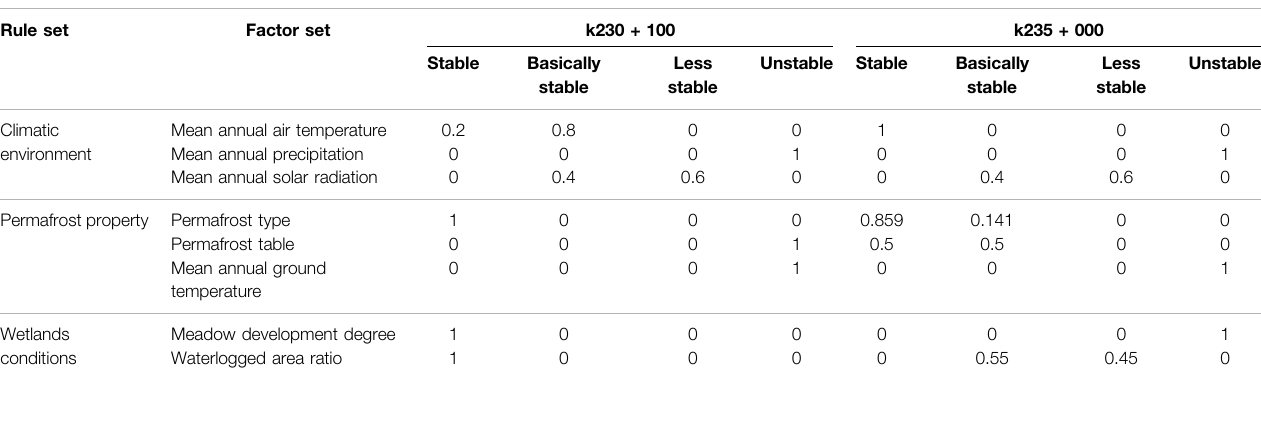
TABLE 8 | Single factor evaluation matrix for factor